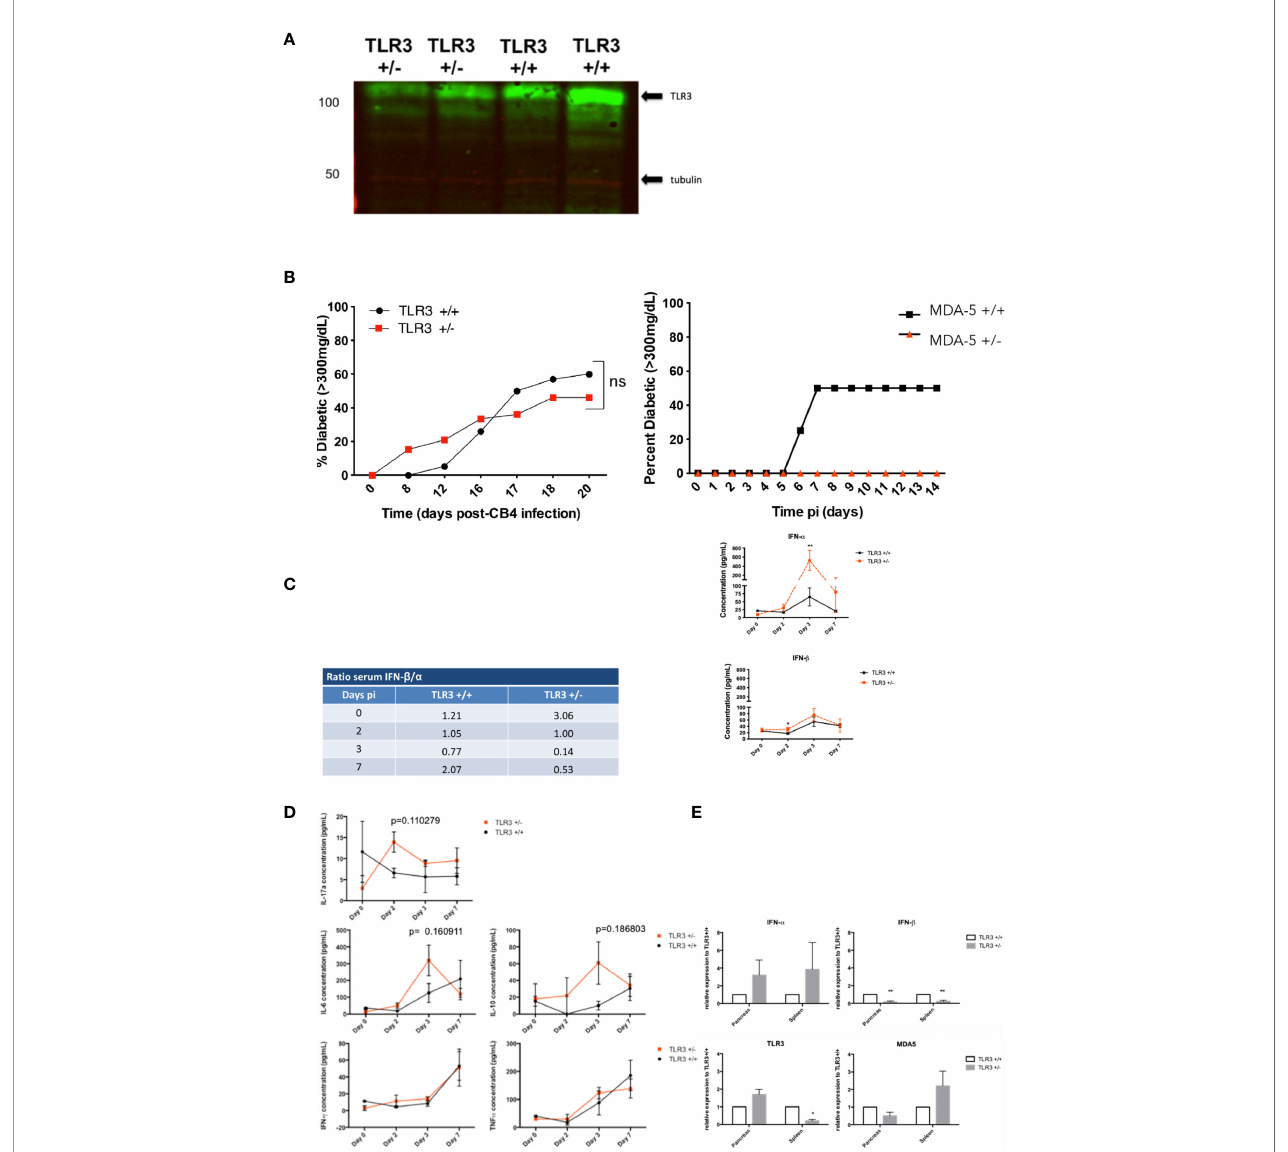
FIGURE 1 | Diabetes incidence in TLR3 +/- and TLR3 +/+ mice post- CB4 infection. (A) TLR3 expression in the spleens of TLR3 +/+, TLR3+/-, and TLR3-/- (not shown) mice that were stimulated with poly I:C as described in Materials and Methods. Twenty-four hours after stimulation, a reduction in TLR3 protein from TLR3 +/- spleens compared to TLR3 +/+ was con fi rmed by Western Blot. (B) TLR3 +/- (n = 13) and TLR3 +/+ (n = 20) (left) and MDA5+/- (n = 15) and MDA5 +/+ (n = 20)(right) were infected ip with 400 pfu CB4. Diabetes incidence was monitored up to 20 days post-infection. Two consecutive blood glucose levels greater than 300mg/dL determined diabetes incidence. Systemic and local in fl ammatory cytokines in TLR3 +/- and TLR3 +/+ mice post-CB4 infection. (C, D) TLR3 +/- (n = 4-8) and TLR3 +/+ (n = 4-8) were infected by an intraperitoneal i.p. injection with 400 pfu CB4. IFN- a / b In fl ammatory cytokine concentrations (pg/mL) were measured from sera by ELISA and IL-6, IL-10, IL-17a, IFN- g , and TNF- a by FACS bead array at days 0, 2, 3 and 7 post-infection (pi). Ratios of the average IFN- b concentrations versus IFN- a (left) and the individual concentrations (right) (C) and averages of in fl ammatory cytokines (D) measured from sera at each time point are shown. (E) Relative mRNA expression levels of TLR3, MDA5, IFN- a and b from the spleen and pancreas of TLR3+/+ (n = 4-8) and TLR3+/- mice (n = 4-8) at day 3 post-CB4 infection were quanti fi ed by quantitative real time PCR and normalized to GAPDH. The comparative Ct method was used to calculate mean relative expression ± SEM against TLR3+/+ mice as described in Materials and Methods section. Data shown are from duplicate samples from two independent experiments. *p < 0.05, **p < 0.01 and ns, not signi fi